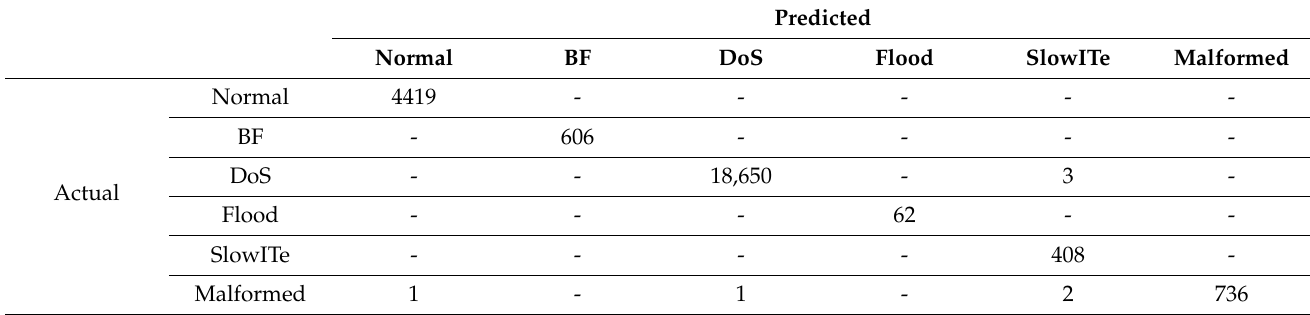
Table 9. Confusion matrix when a connection ACK is not